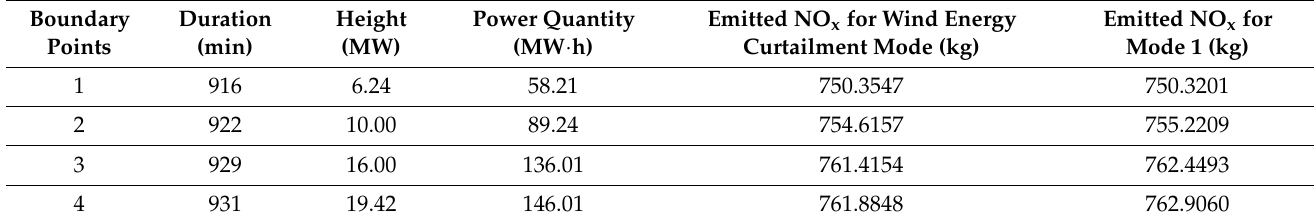
Table 6. Wind energy curtailment boundary with NO x net emission reduction as the decision